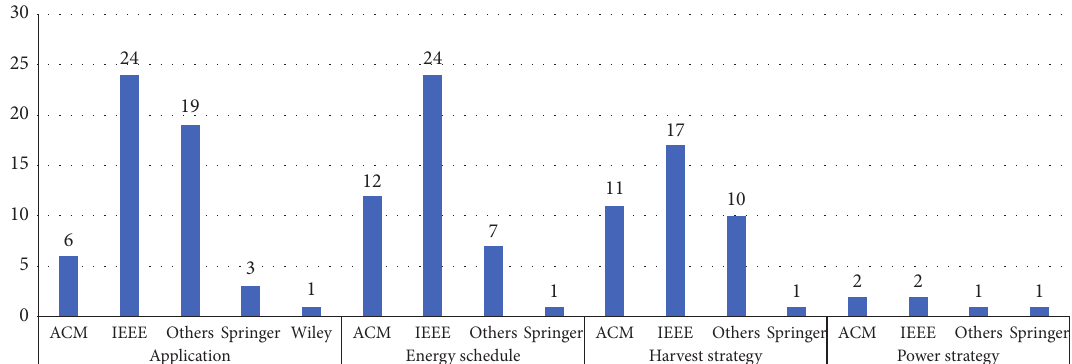
Figure 11: Statistics of the included papers in four different categories by publishers.